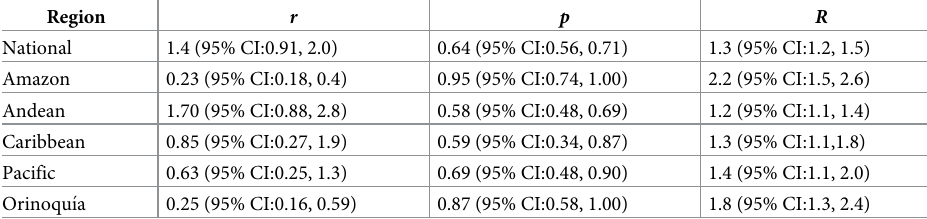
Table 4. Estimates of reproduction number ( R) , growth rate parameter (r) and deceleration of the growth param- eter ( p ) obtained from the renewal equation method utilizing the GGM for the early ascending phase of the epi- demic (30 days) at the national and regional level at α =